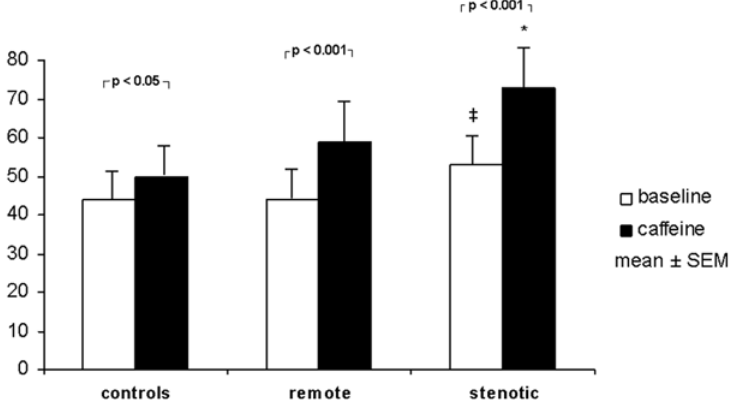
Figure 3. Coronary resistance during physical exercise. Coronary resistance at exercise increased in all groups. A massive increase in resistance was found in stenotic segments. { P , 0.05 for the comparison versus remote. * P , 0.05 for the comparison versus remote segments and age-matched controls.